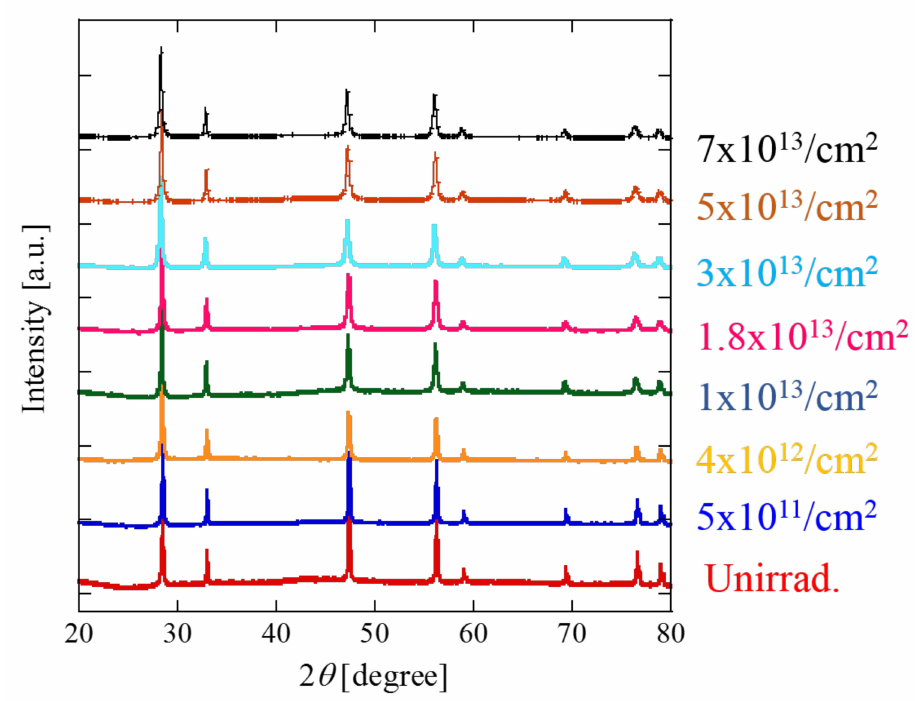
Figure 1. Widely scanned XRD spectra for unirradiated and irradiated CeO 2 specimens. Xe ion fluences are shown at the right side of the figure.